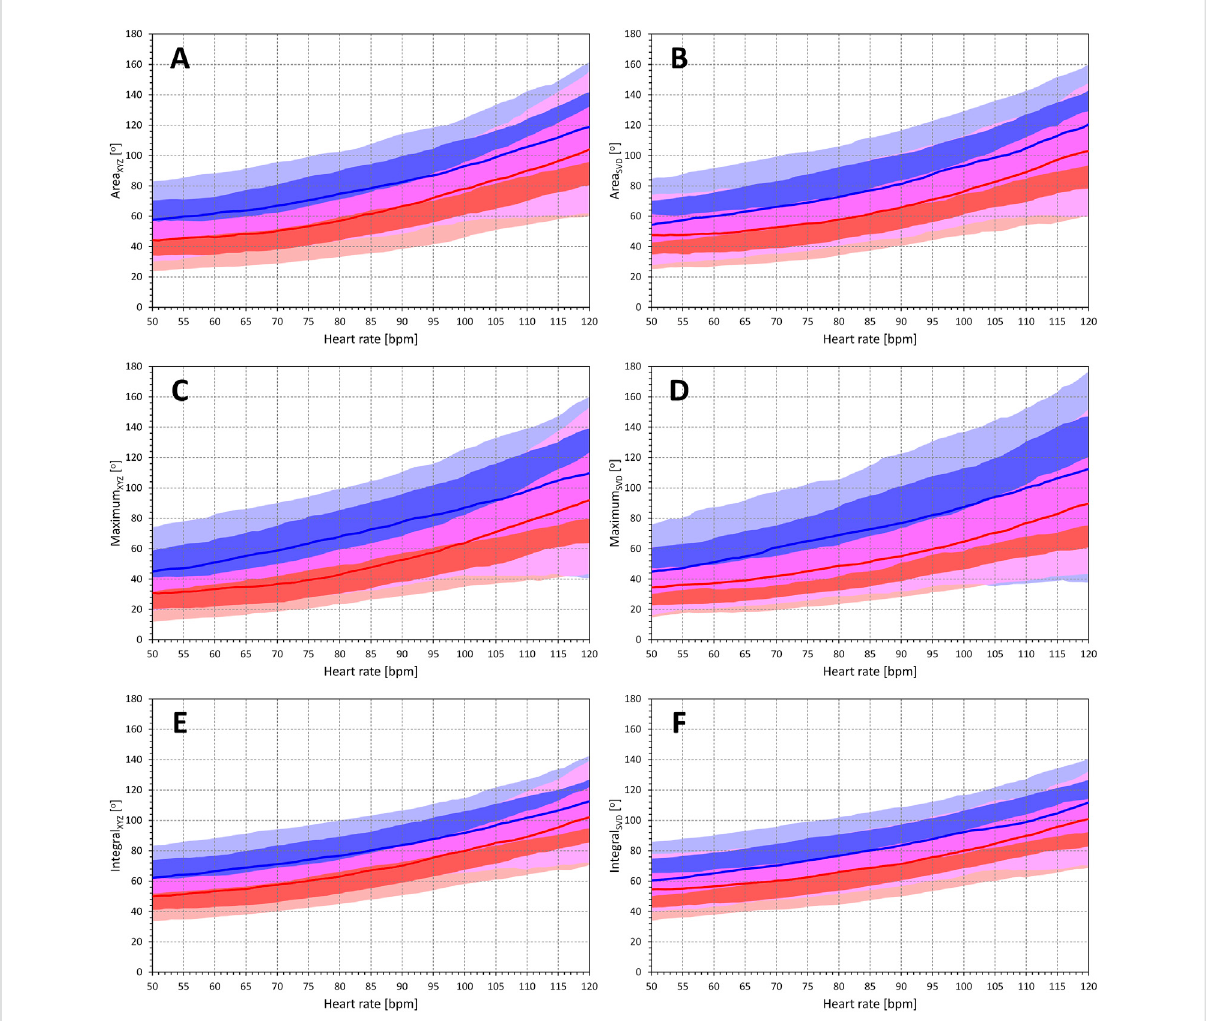
FIGURE 10 Population pro fi les of QRS-T angle relationship to underlying heart rate. Each panel of the fi gure corresponds to a different QRS-T angle expression andshows thesummaryofpopulationdistributionsofintra-subjectcurvaturesofsecond-degree polynomialregressions between QRS- T angle measurements and heart rate measured over the preceding 1 min. Bold red and blue lines show point-by-point median values of the regression curvatures in female and male subjects, respectively. The red and blue bands show the point-by-point inter-quartile ranges of the curvature values in females and males, respectively; the violet bands show the overlaps between the inter-quartile ranges between both sexes. The light red and light blue bands show the 10% – 90% ranges of the curvature values in females and males, respectively; the light violet bands show the overlaps betweenthe 10% – 90% ranges betweenboth sexes. The bands of inter-quartile ranges including their sex overlap are shown overlaying the 10% – 90% bands. Panels (A – F) correspond to Area XYZ , Area SVD , Maximum XYZ , Maximum SVD , Integral XYZ , and Integral SVD QRS-T angle expressions,